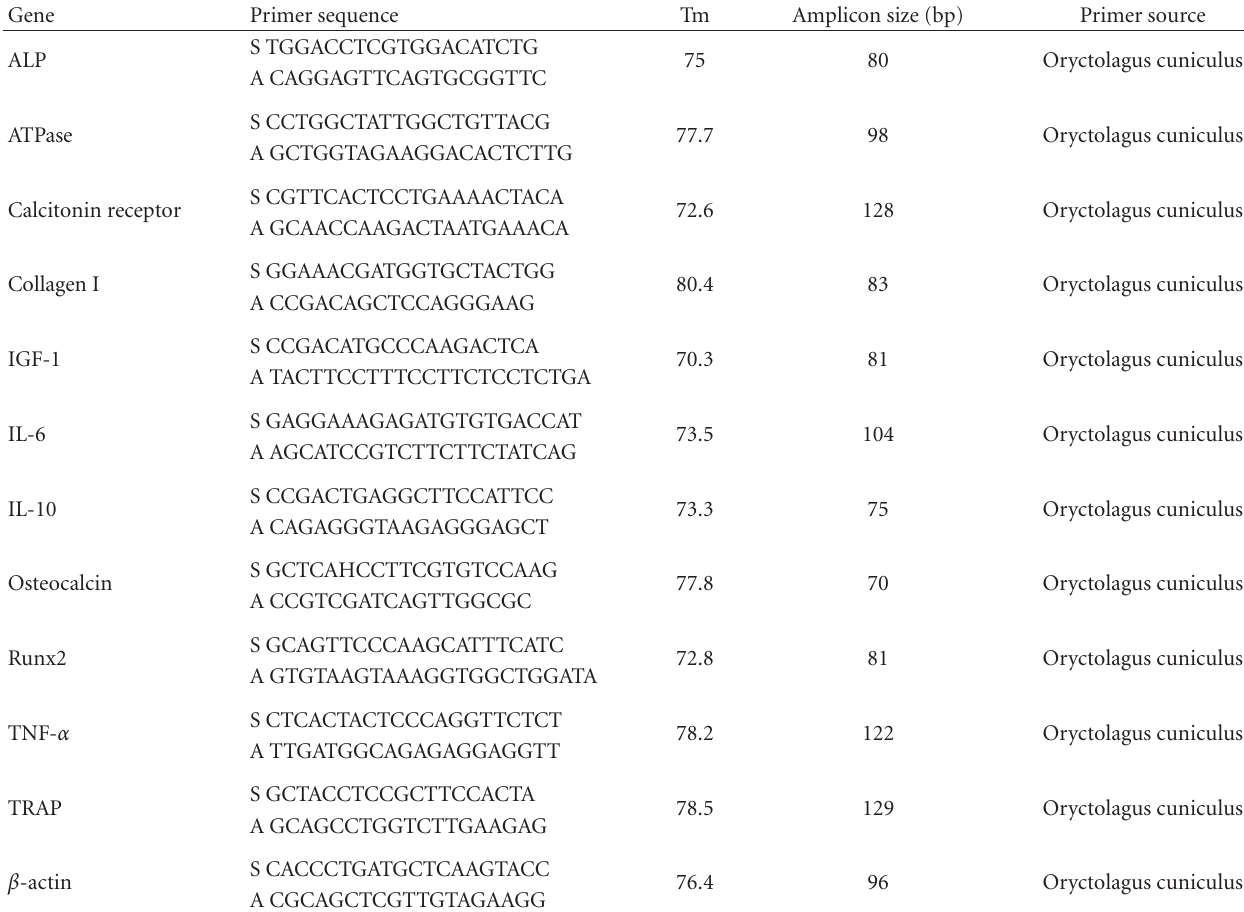
Table 1: Primers used and specific parameters of the real-time